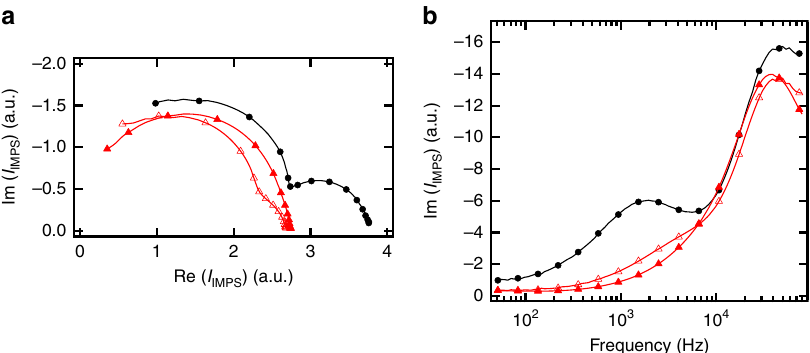
Figure 3 | IMPS spectra. Nyquist plot ( a ) for PSCs prepared with no treated TiO 2 electrode (in black at 0.15mAcm -2 ) and with Li-doped TiO 2 electrode at 0.07mAcm -2 (open triangle) and 0.26mAcm -2 (closed triangle). ( b ) Imaginary component of the same IMPS shown in a versus the frequency.